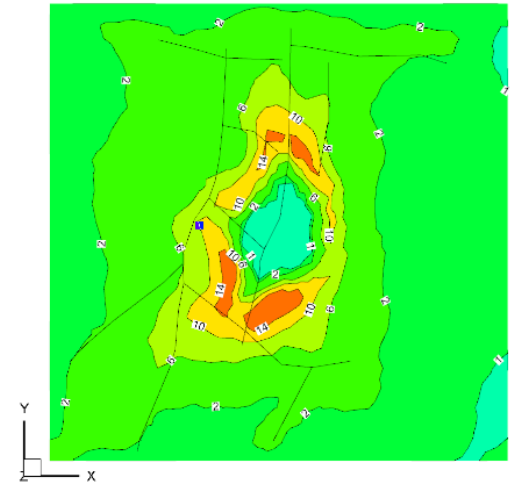
Figure 20. Total molar fraction of CO 2 and N 2 after 30 days’ injection.